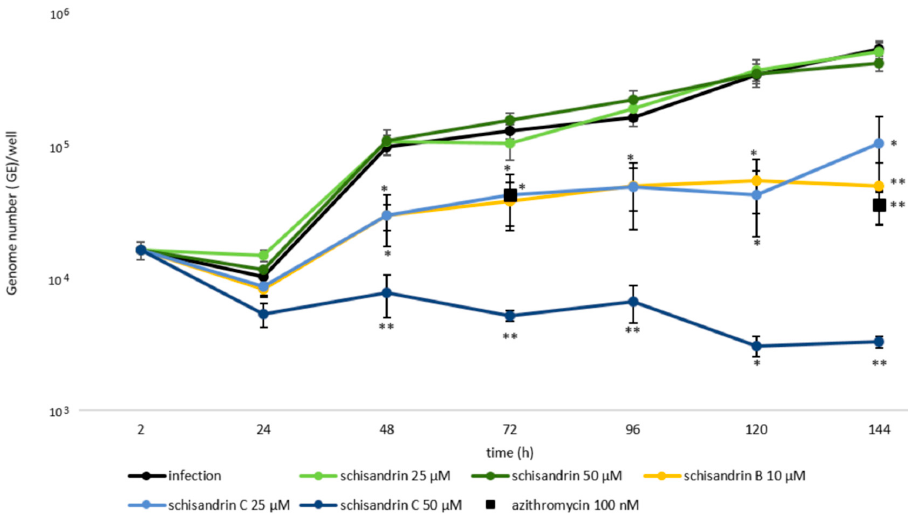
Figure 2. Impact of dibenzocyclooctadiene lignans on C. pneumoniae growth kinetics in THP-1